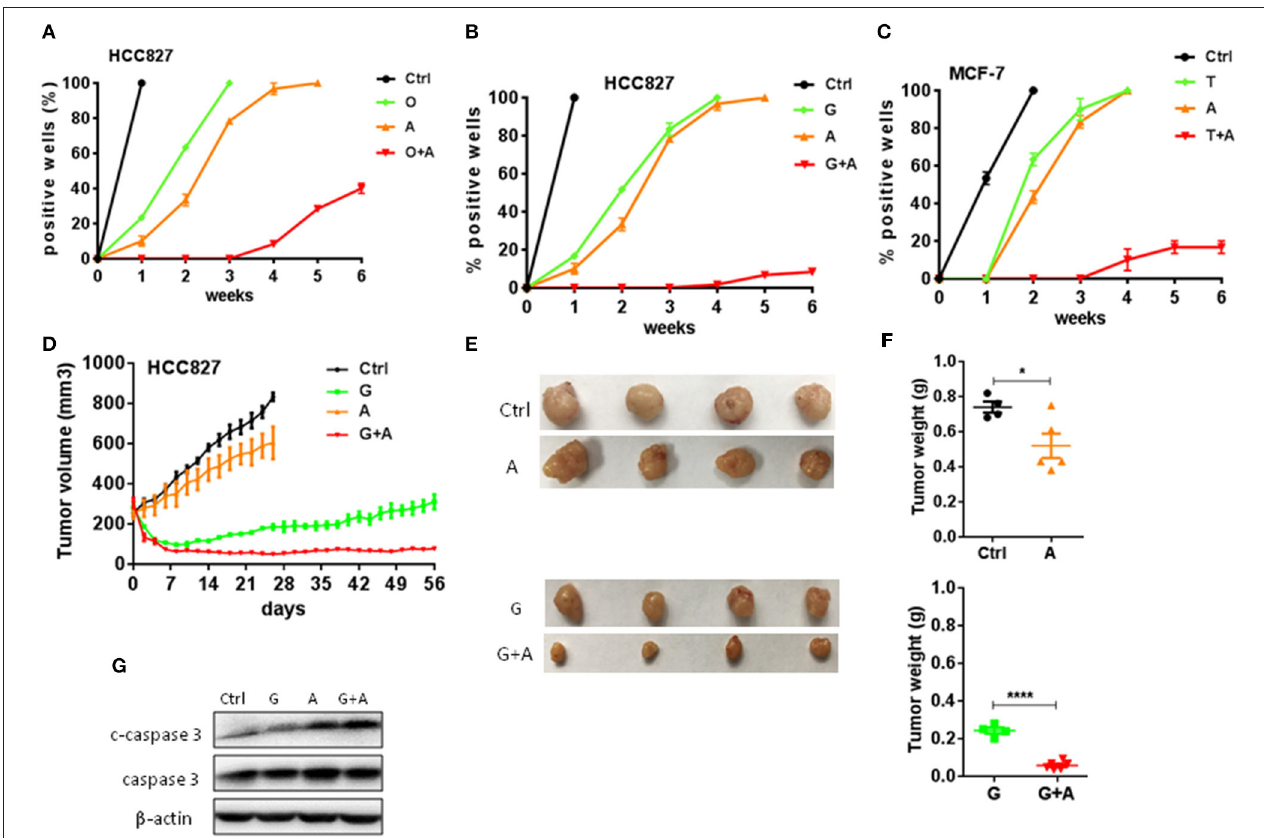
FIGURE 3 | Aspirin delayed the emergence of acquired resistance to targeted therapy in lung and breast cancers. (A–C) The indicated cells (200–500/well) were seeded and treated in a 96-well plate, and wells of 50% or greater confluence were scored as positive weekly and graphed means ± SEM. Each experiment was repeated two times. (A) HCC827 cells were treated with 10nM O, 2mM A, or O + A. (B) HCC827 cells were treated with 10nM G, 2mM A, or G + A. (C) MCF-7 cells were treated with 2 µ M T, 2mM A, or T + A. (D–F) HCC827-derived xenograft tumors were treated with PBS, 12.5 mg/kg/day G, 100 mg/kg/day A, or G + A. The growth curve (D) , the photographs (E) and the weight of tumors (F) . (G) Western blot analysis of c-caspase 3 and caspase 3. β -actin was used as loading control. The data are presented as the means ± SEM. Student’s t -test was used. * P < 0.05; **** P <